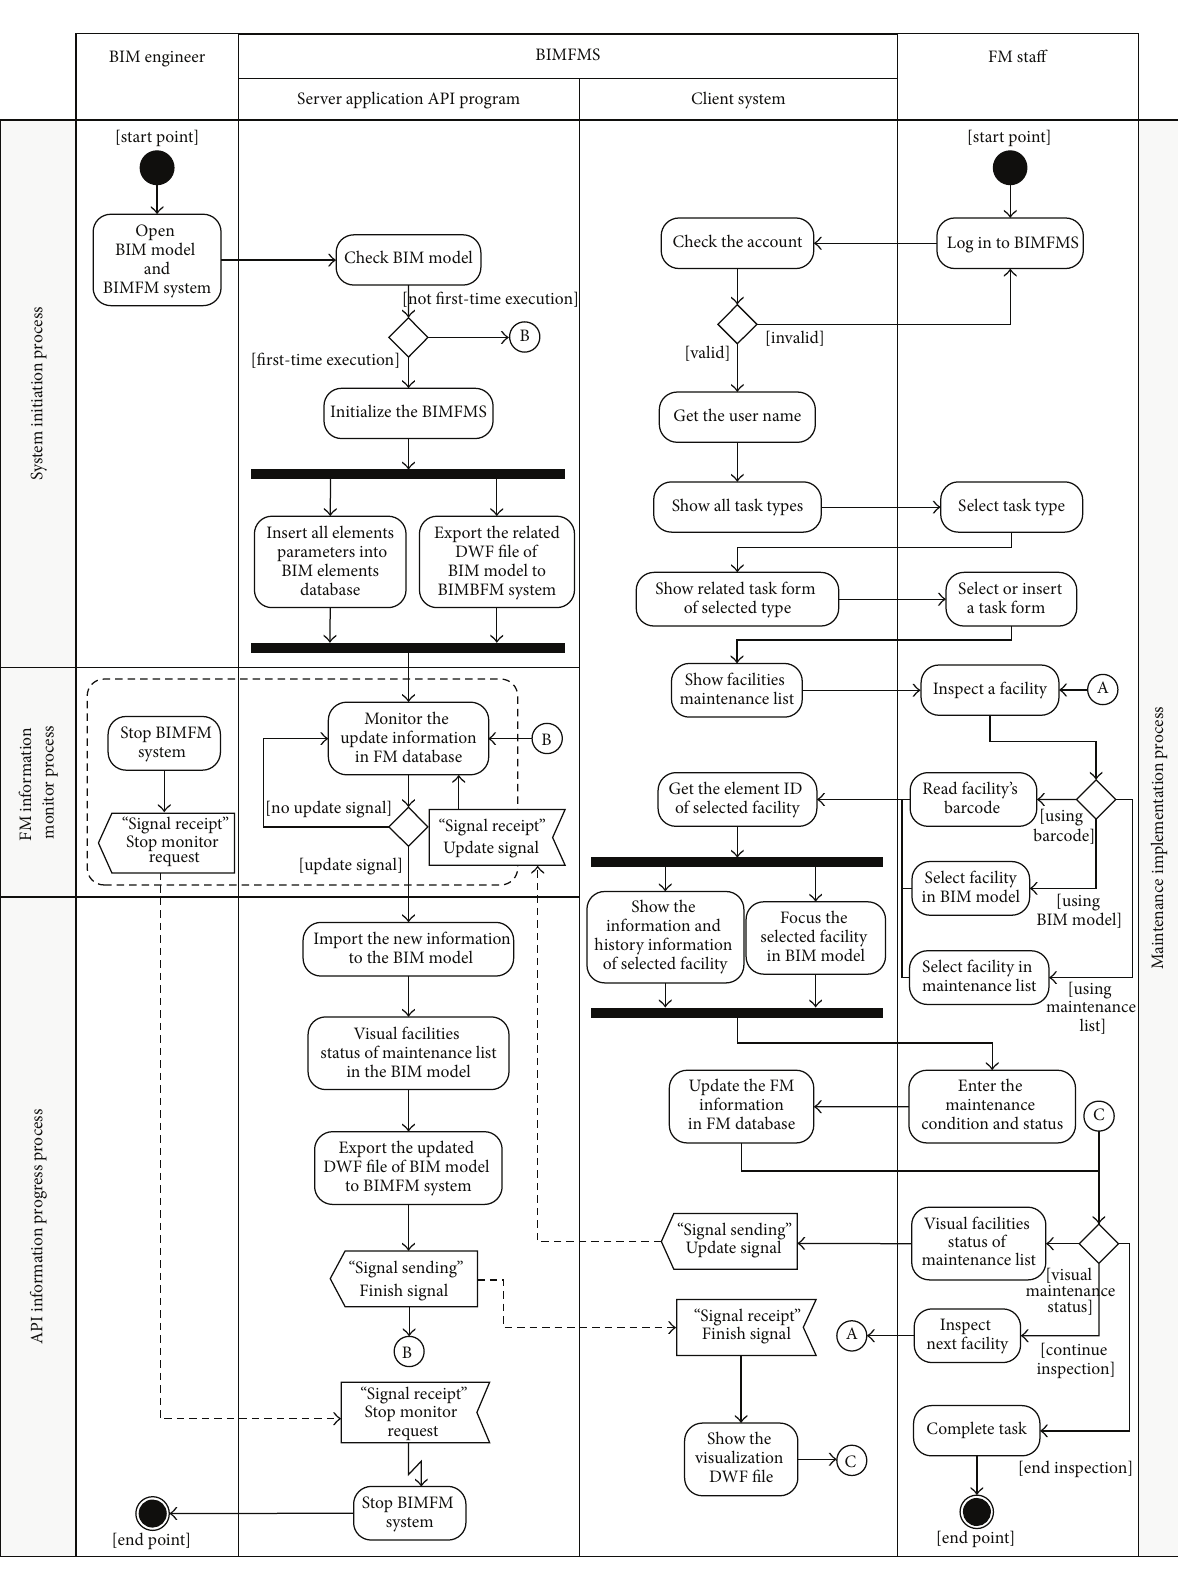
Figure 3: The system process flowchart used in the BIMFM